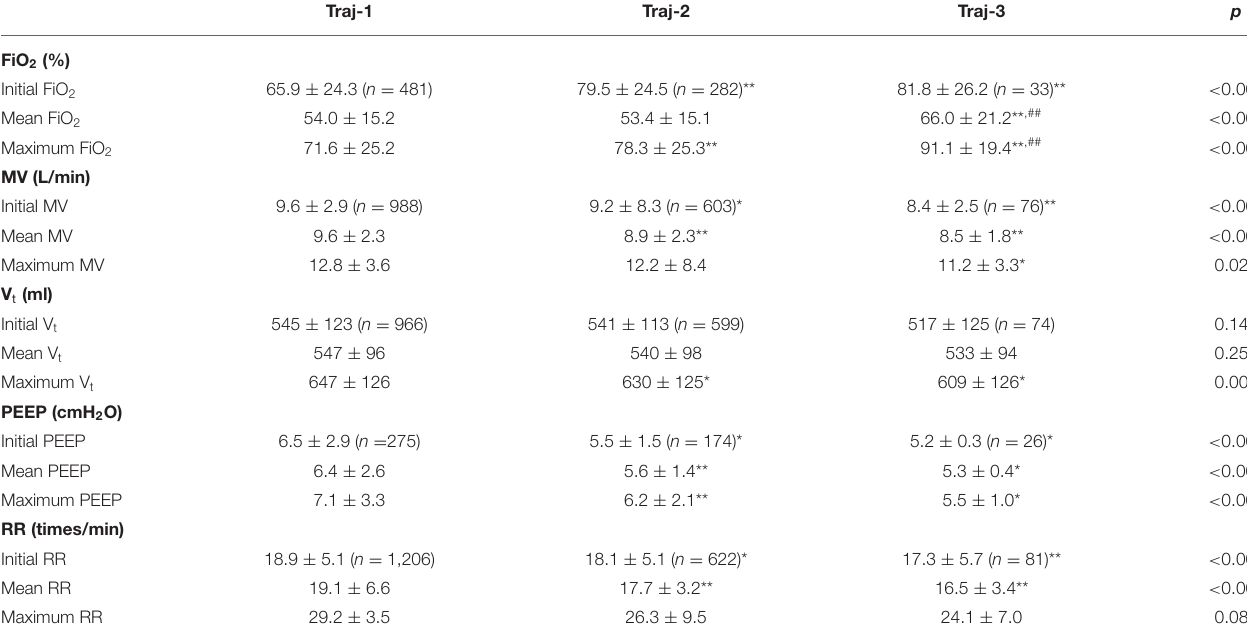
TABLE 3 | Respiratory parameters according to the partial pressure of oxygen